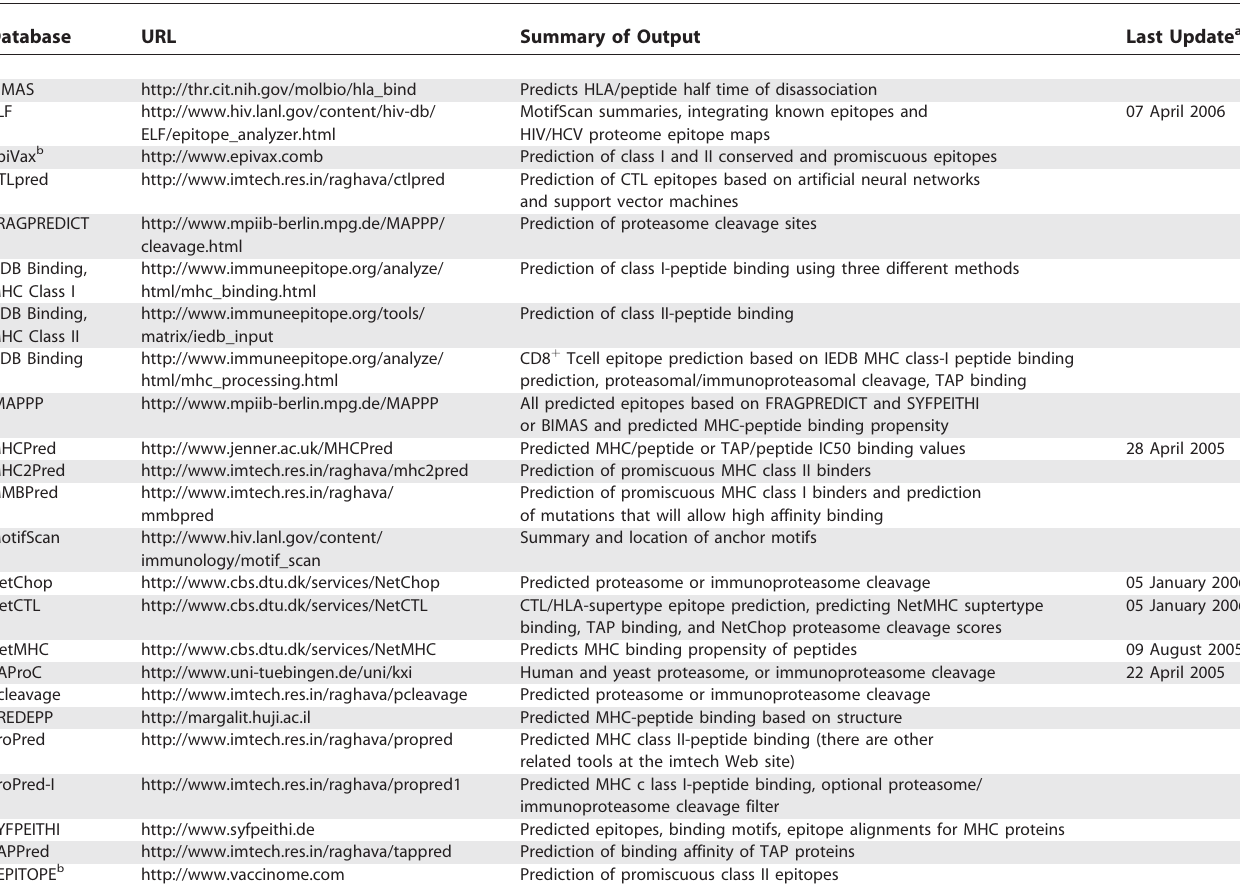
Table 1. Web-Based Interactive Tools for T Cell Epitope Prediction